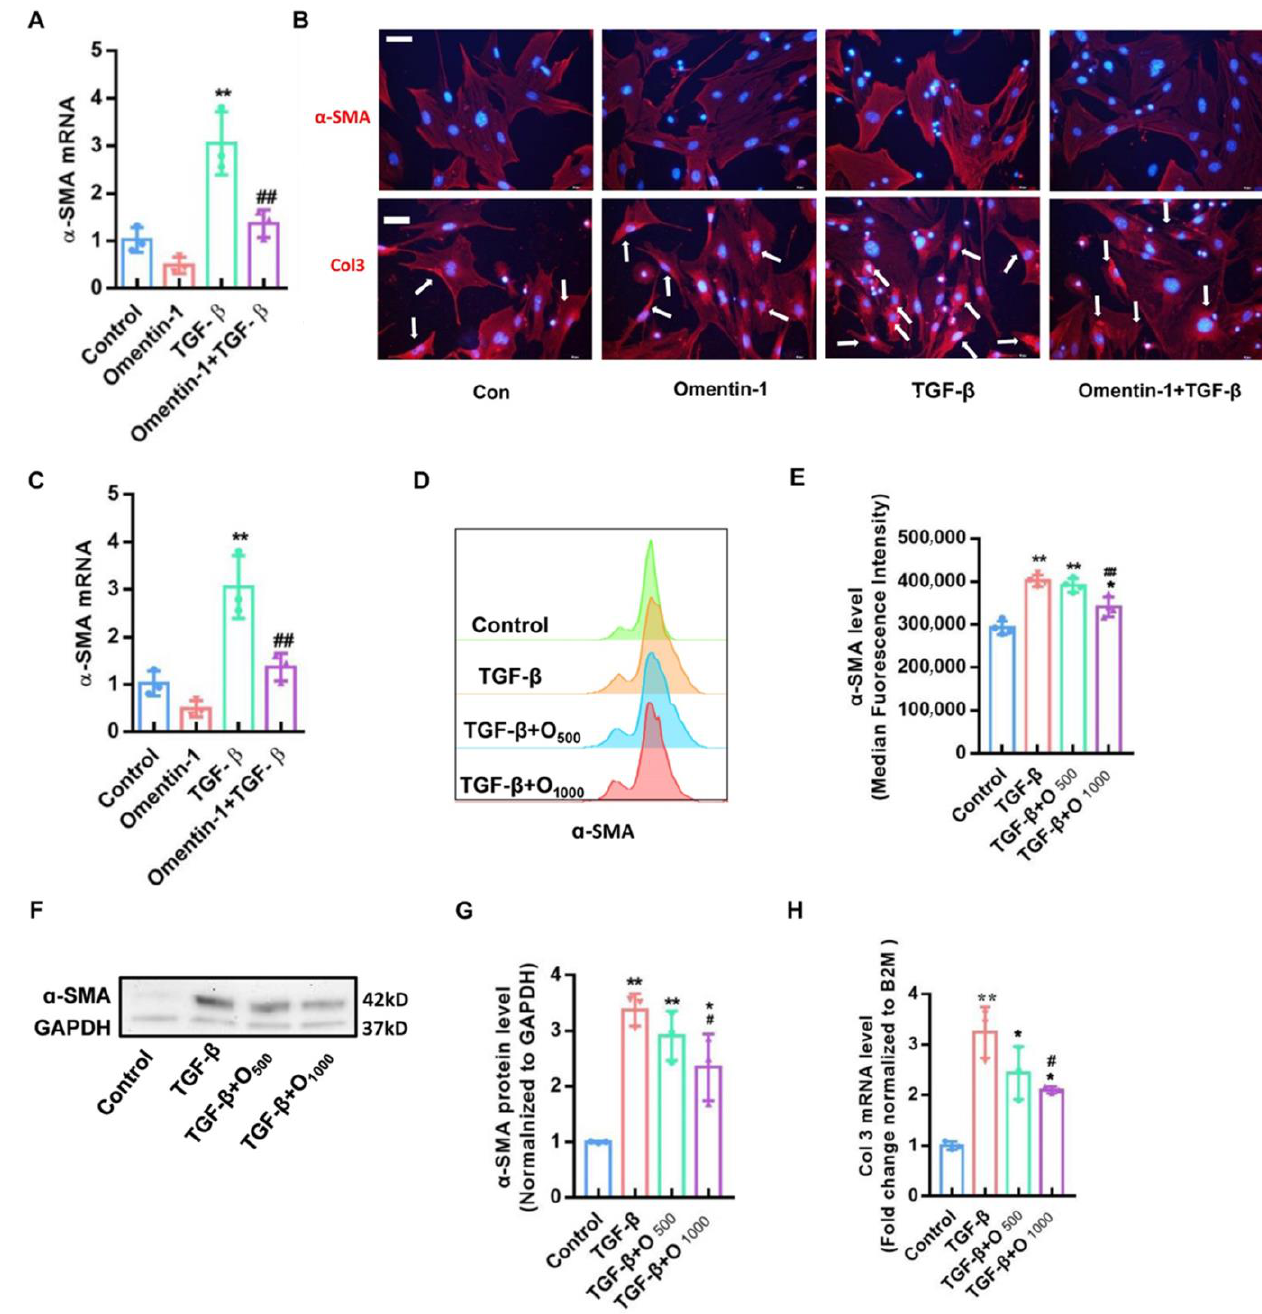
Figure 5. The effect of omentin-1 on TGF-β activated myofibroblast in vitro. ( A ) The mRNA level of α-SMA detected by qPCR in mouse lung fibroblasts ( n = 3); ( B ) Immunofluorescence for α-SMA and Col3 in mouse lung fibroblasts (Bar = 25 μm, n = 3), White arrows indicate cells with α-SMA upregulation. ( C ) The mRNA level of α-SMA detected by qPCR in HLFs ( n = 3); ( D ) α-SMA level in HLFs detected by Flow cytometry ( n = 4); ( E ) Median Fluorescence intensity of α-SMA in HLFs. ( F )The content of α-SMA in HLFs detected by Western blotting with cropping gel at the relative molecular size ( n = 3); ( G ) Semi-quantitative analysis of α-SMA level evaluated by Western blotting; ( H ) The mRNA level of Col3 in HLFs detected by qPCR ( n = 3). The data are presented as the mean ± SD. * p < 0.05, ** p < 0.01 vs. control group, # p < 0.05 vs. TGF-β group, ## p < 0.01 vs. TGF-β group.